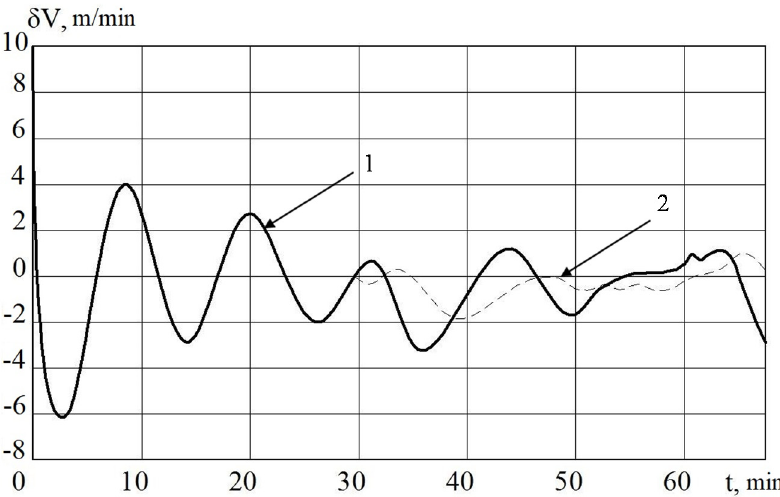
Figure 3. INS errors in determining the velocity with regulator (1) and non-linear regulator (2).